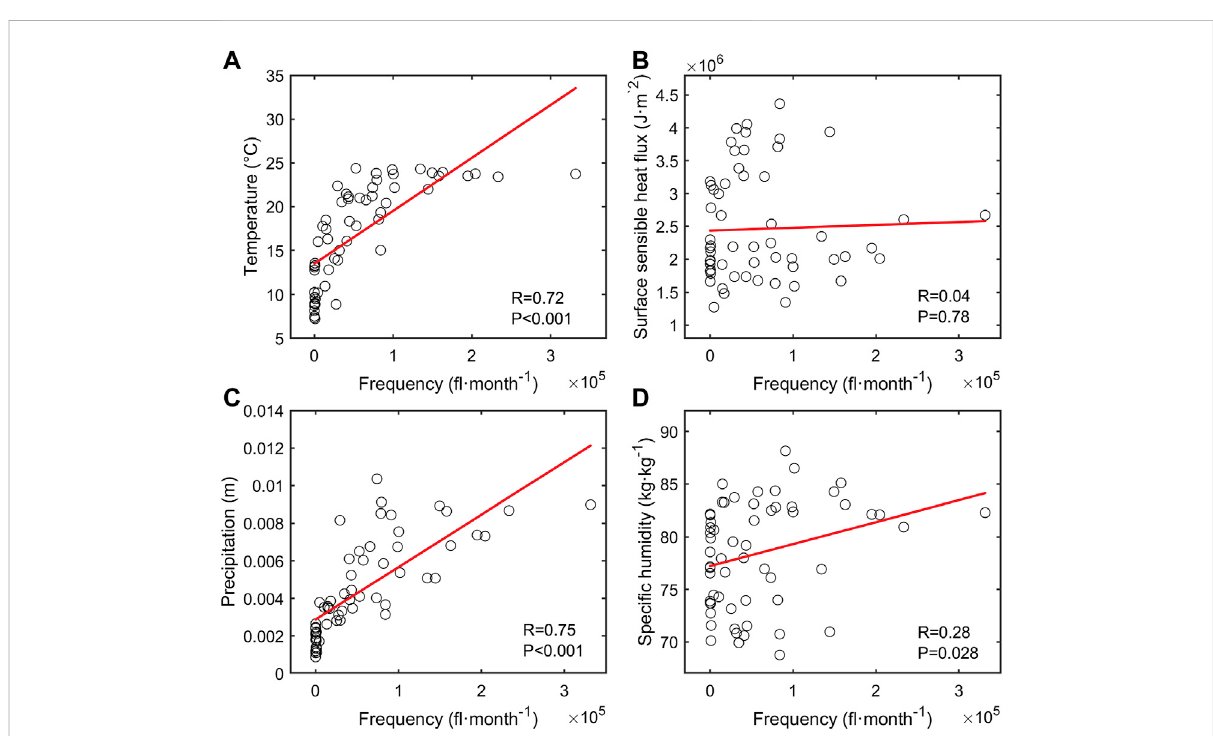
FIGURE 9 The correlations between monthly lightning frequency in the 5 years from 2016 to 2020 and the meteorological factors selected in the corresponding time and region: (A) Temperature, (B) Surface sensible heat fl ux, (C) Precipitation, and (D) Speci fi c humidity (850 hPa). R represents the value of correlation coef fi cient and p shows the signi fi cance